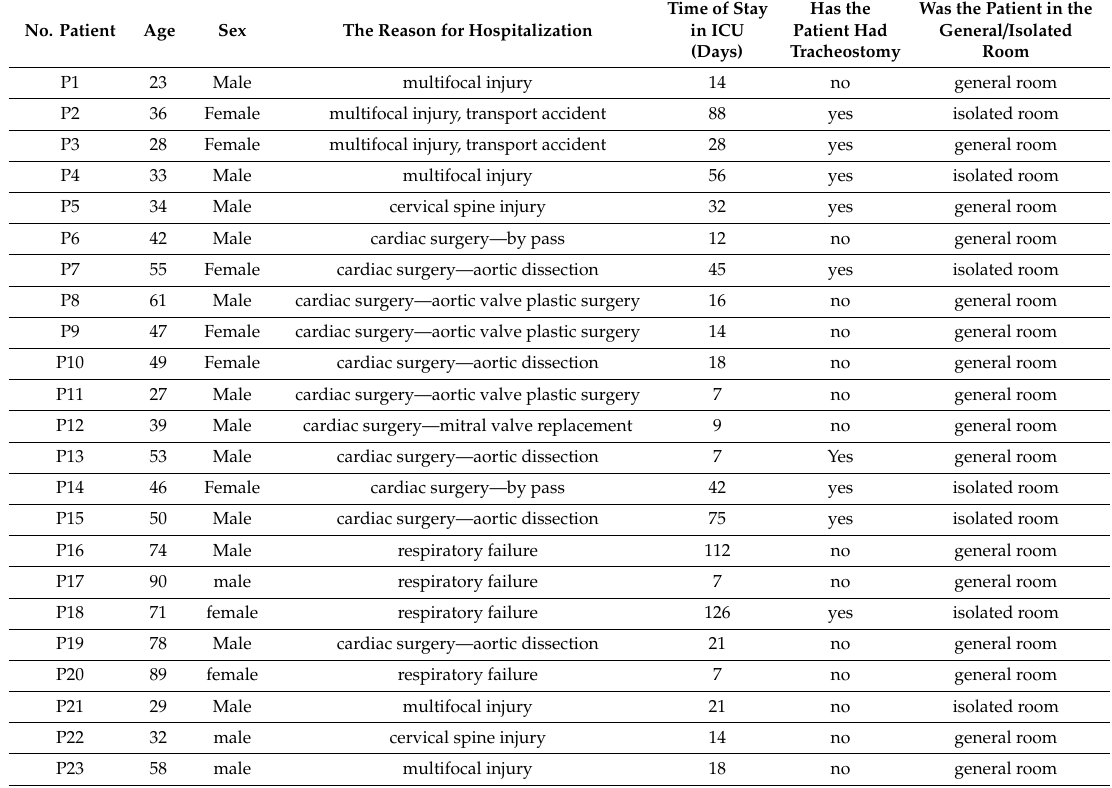
Table 1. Basic data of patients undergoing testing. ICU, Intensive Care